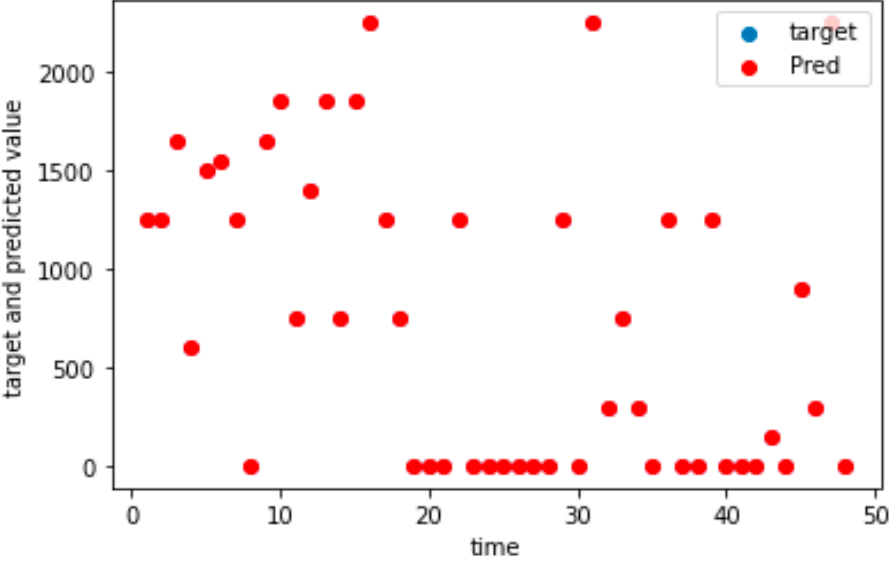
Figure 8. Target and predicted charging demand in kW.